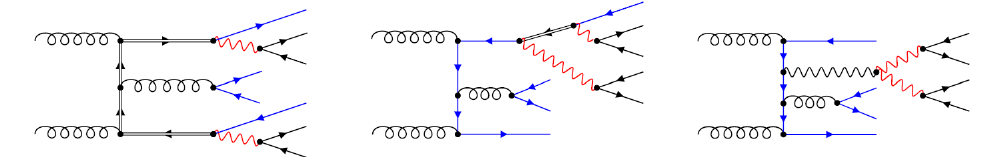
Figure 1: Representative Feynman diagrams for double- single- and non-resonant b µ − ¯ ν µ ¯ bb ¯ b + X contributions to pp → e + ν e